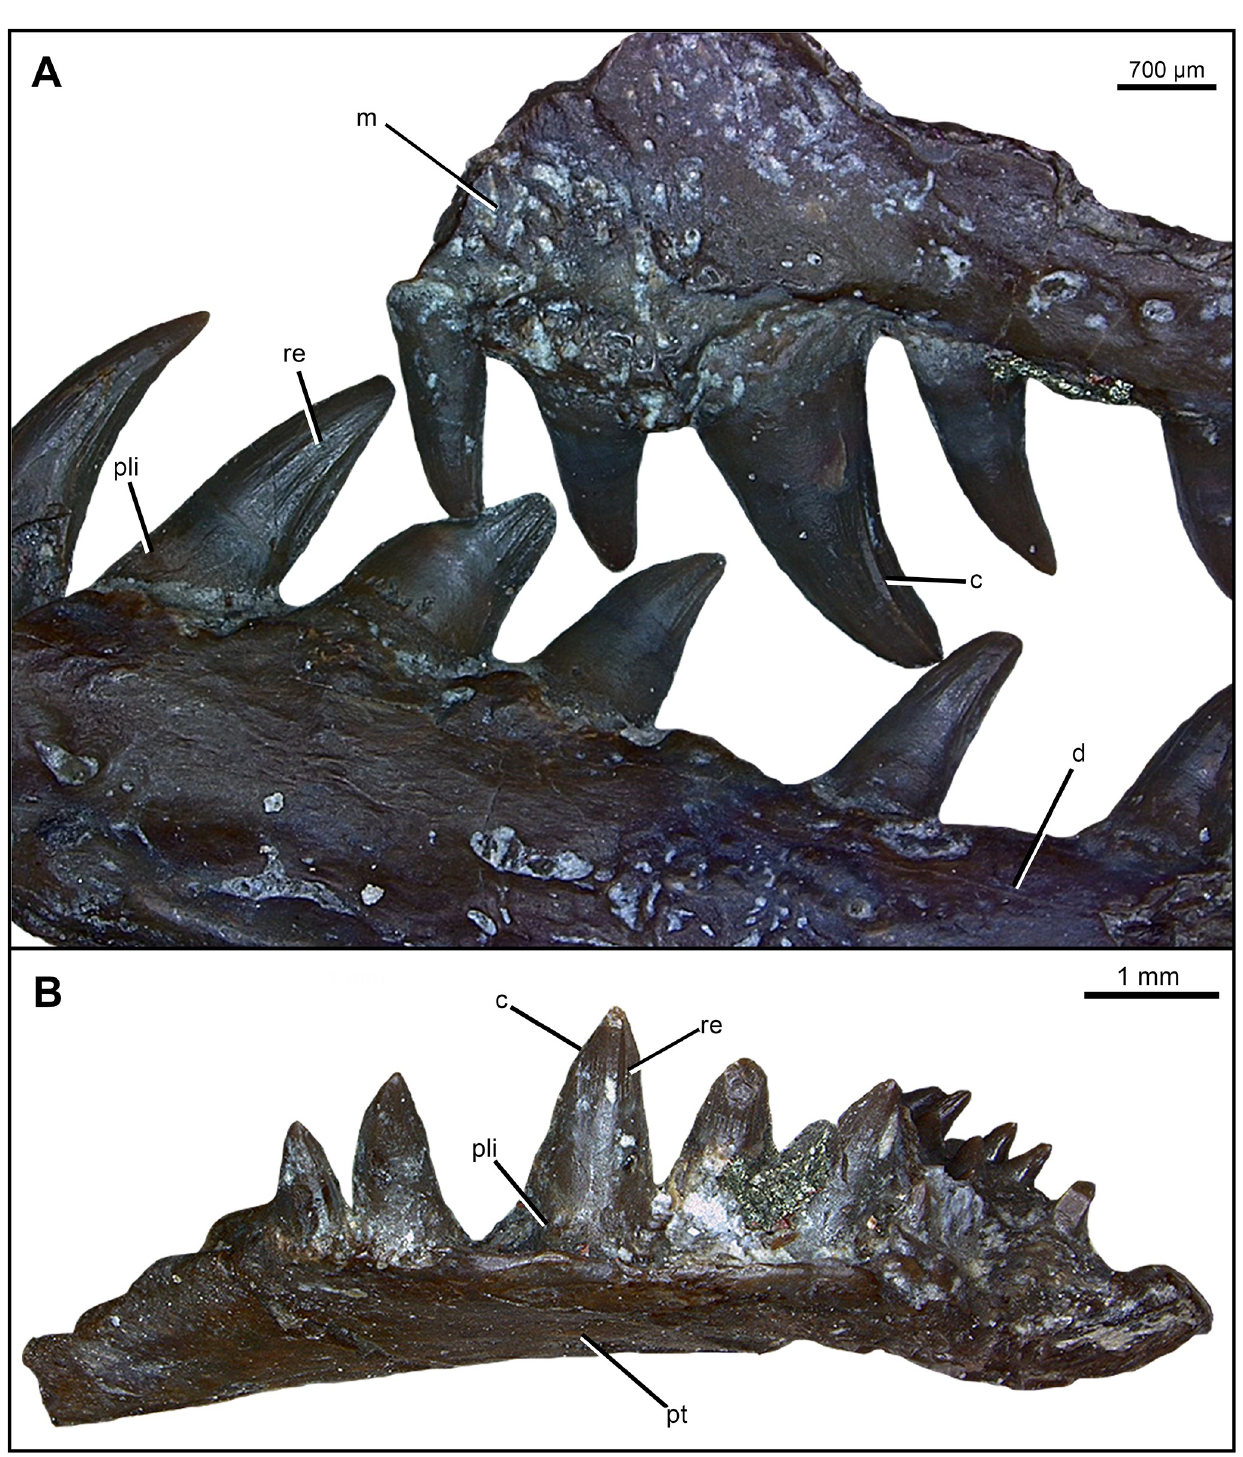
Fig 2. Specimen photograph displaying vertical reeding on the tooth crown of dentary, maxilla, and transverse flange of the pterygoid in Maiothisavros dianeae (ROMVP 87366). (A) left dentary and maxilla in lateral view, (B) transverse flange of the pterygoid in posterior view. Abbreviation: c, carina; d, dentary; re, reeding; m, maxilla; pli, plicidentine; pt, pterygoid.